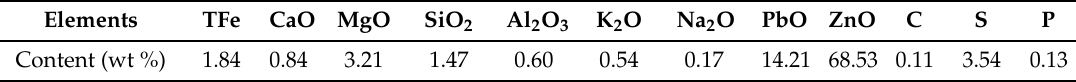
Table 3. Chemical composition of obtained ZnO rich dust.